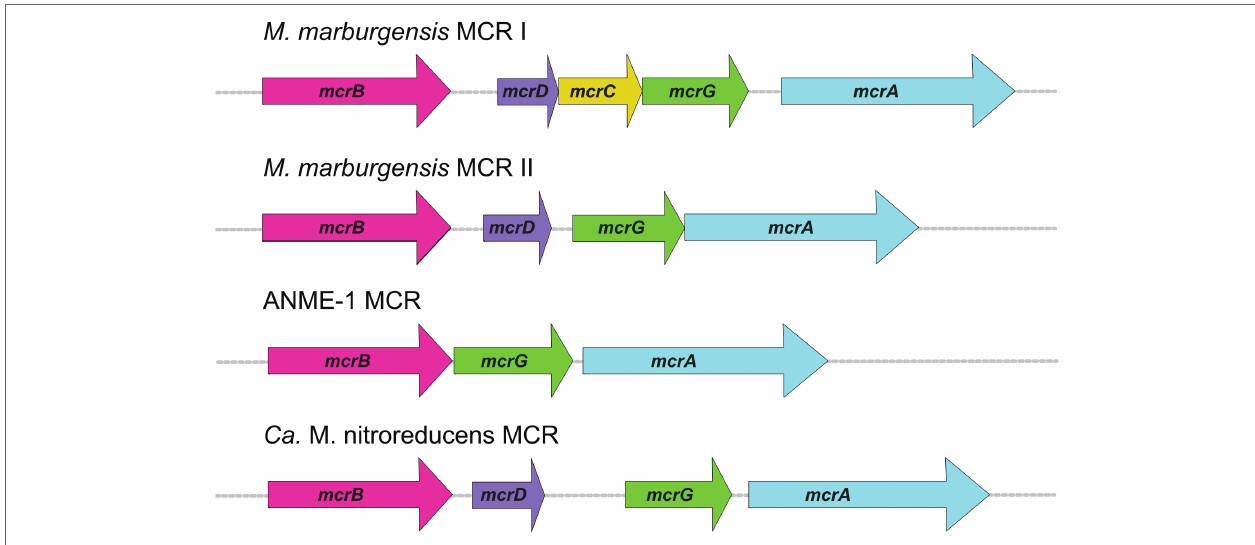
FIGURE 5 | MCR operon organization in selected